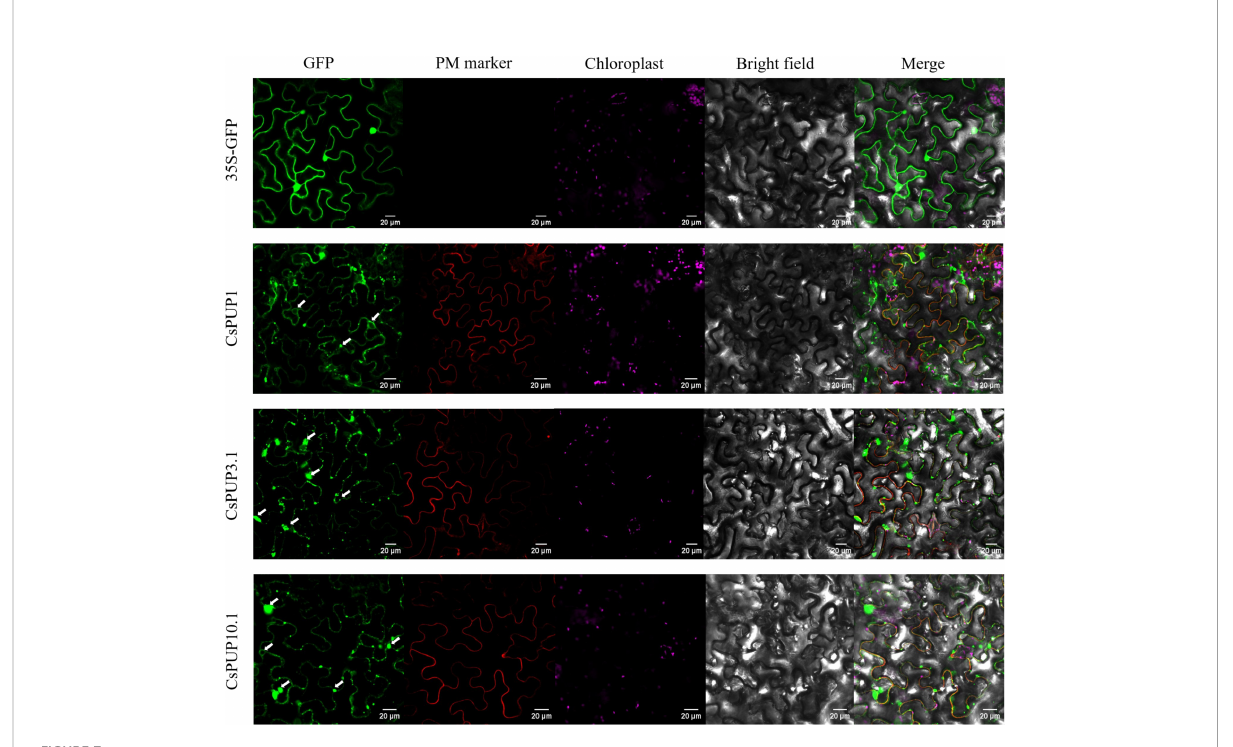
FIGURE 7 Subcellular localization of CsPUP1, CsPUP3.1 and